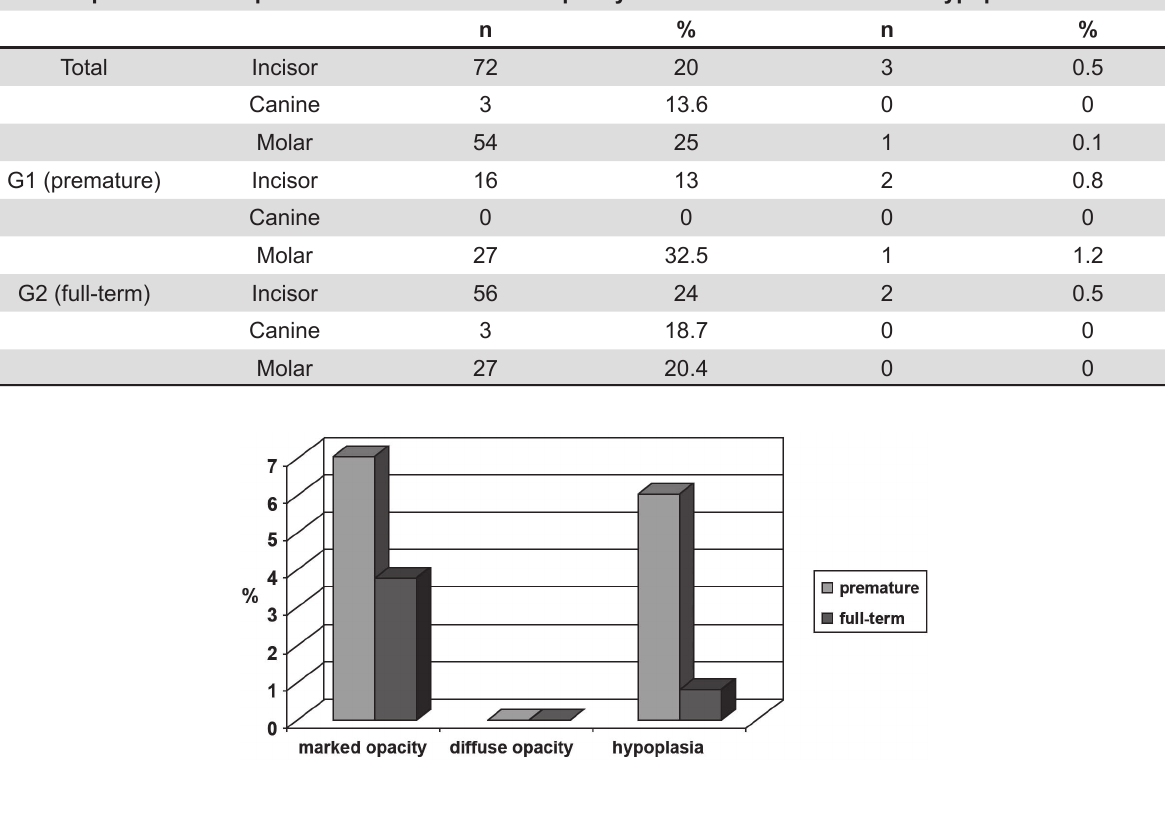
Table 3- Percentage of permanent teeth with opacity and hypoplasia in G1 and G2 Sample